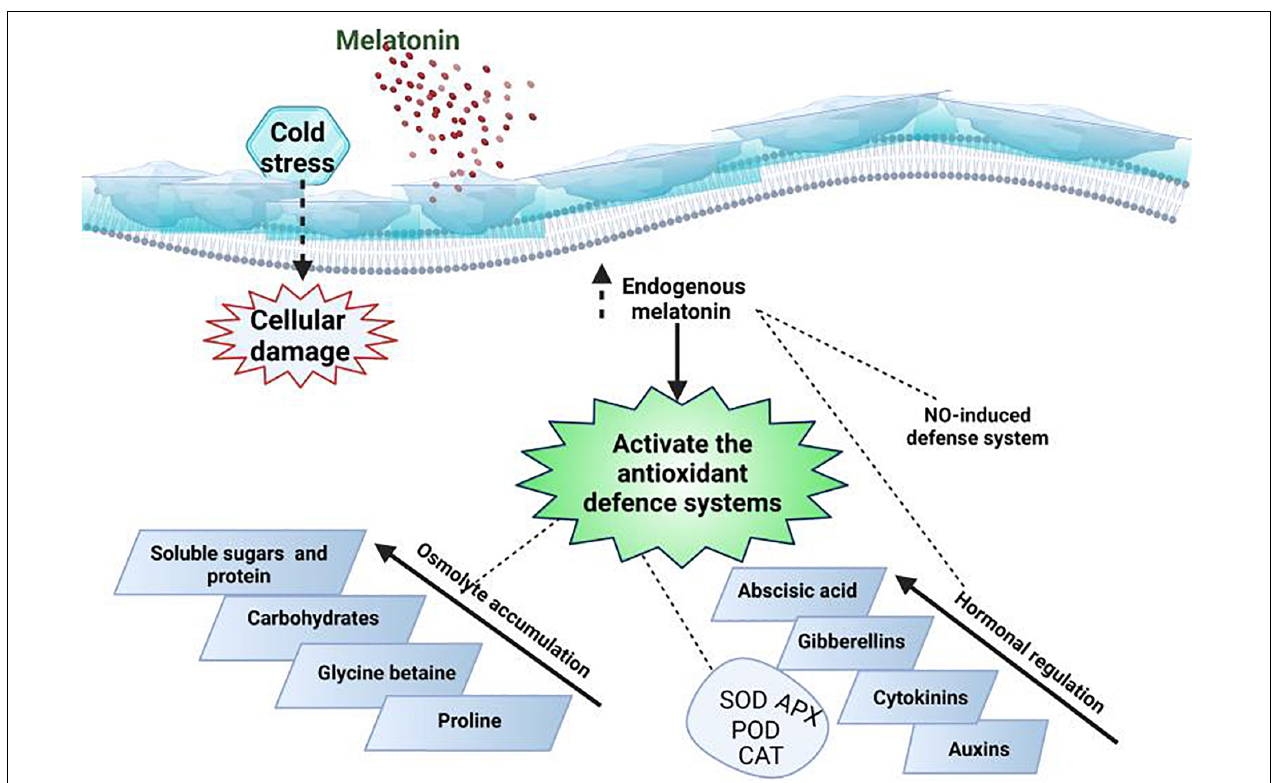
FIGURE 5 | A proposed model of MT mediated increase in anti-oxidant activities and osmolytes accumulation for conferring cold stress in plants. NO: nitric acid.